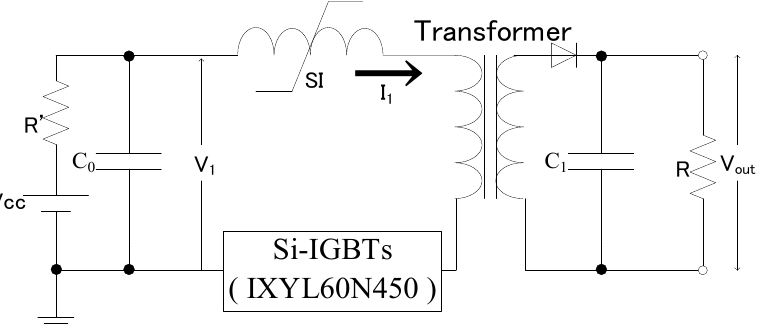
Figure 1. Impulse voltage generator circuit diagram. In this structure, the charged primary capacitor was discharged by a semiconductor, and the voltage was boosted using a transformer.